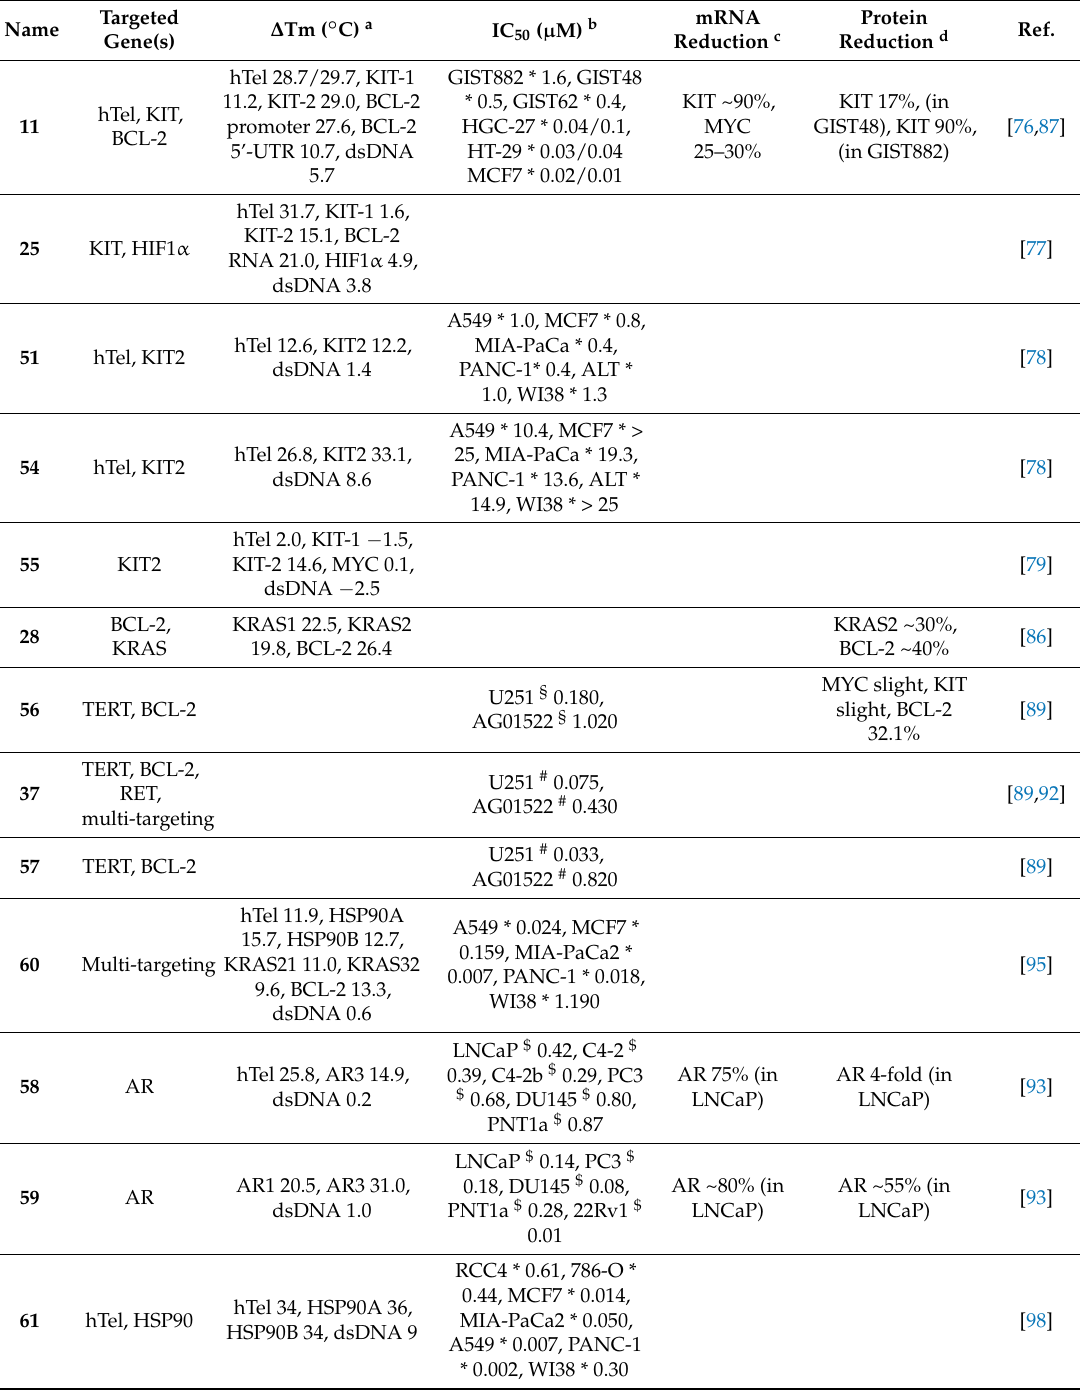
Table 4. In vitro and cellular data of NDIs used to target gene